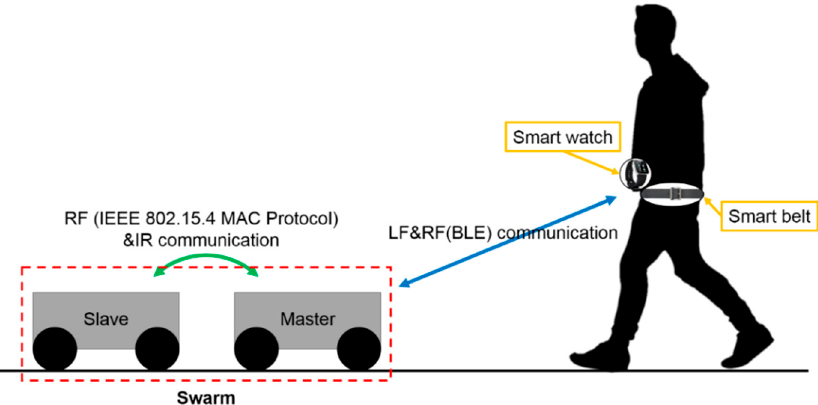
Figure 3. Overall setup of the Pet-Bot system to support swarm-driving.